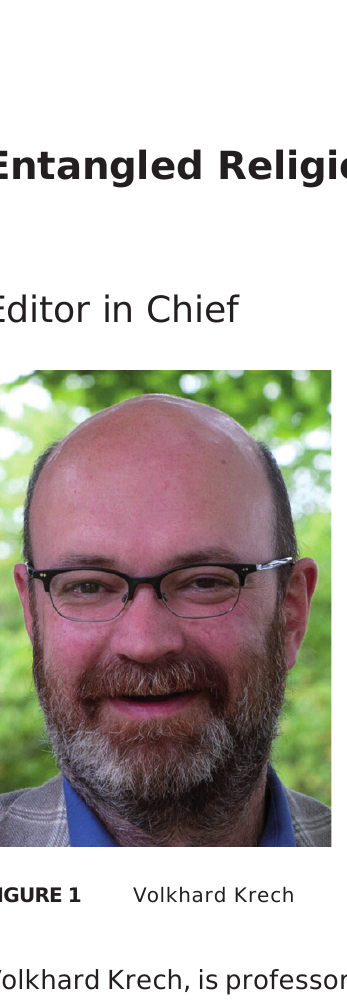
Volkhard Krech, is professor of Religious Studies at Ruhr-University Bochum, director of the Käte Hamburger Kolleg “Dynamics in the History of Religions between Asia and Europe” and director of the Center for Religious Studies Research Department